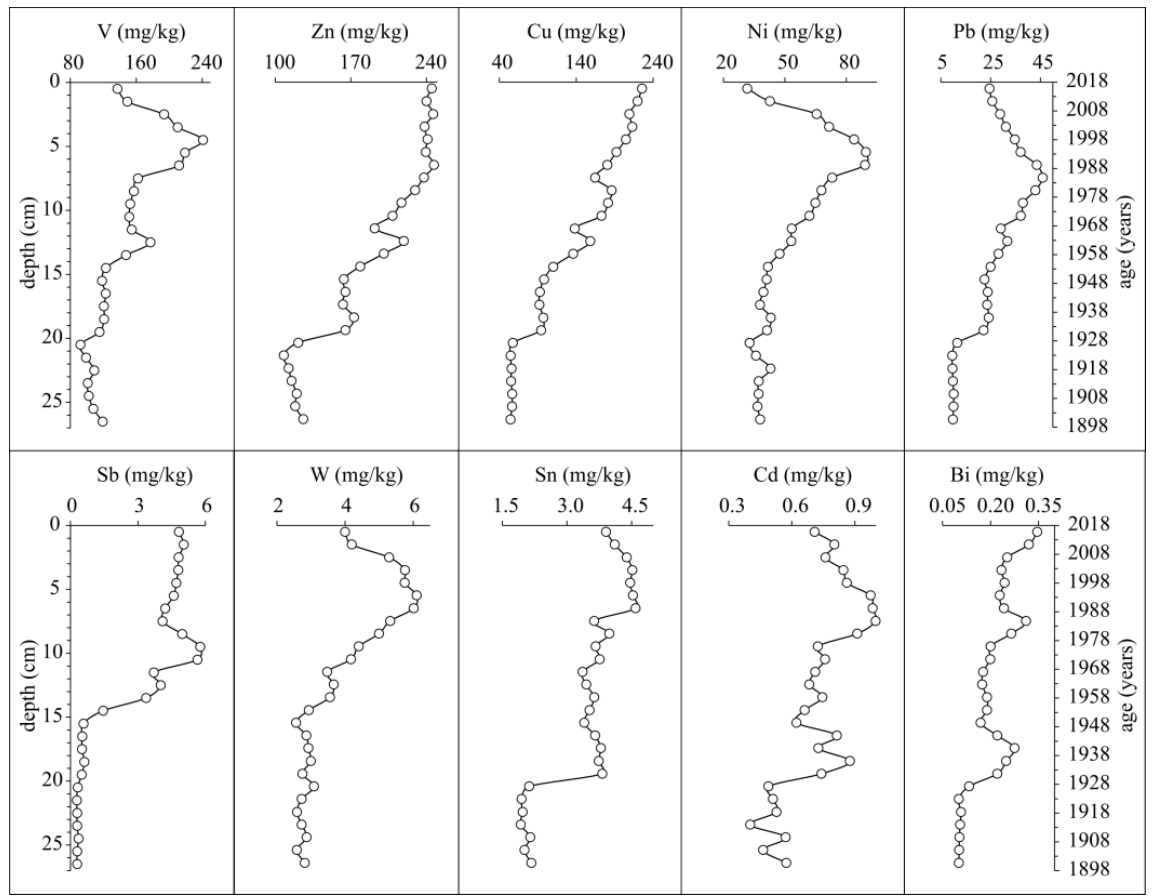
Figure 9. The vertical distribution of heavy metals in sediments of Lake Bolshoi Vudjavr (Murmansk Region) [39,41].